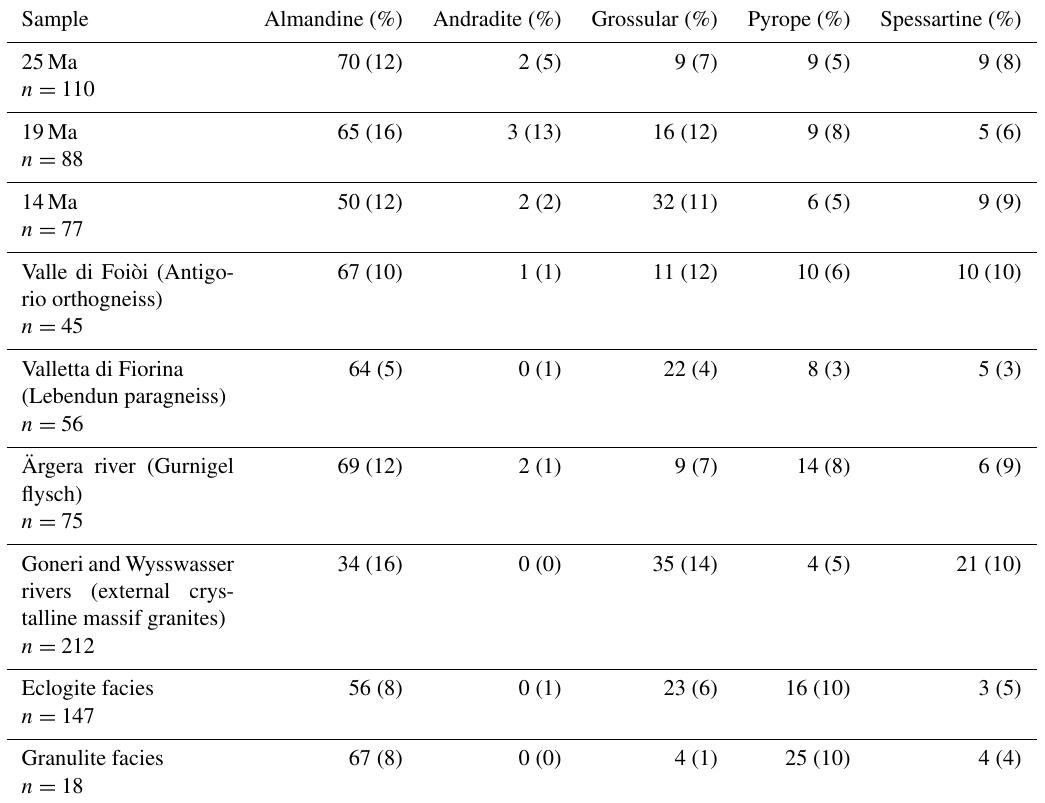
Table 3. Average contents (including standard deviation in brackets) of the five common garnet endmembers in the Molasse sandstones, the fluvial samples from the Lepontine gneisses and the Gurnigel flysch (this study), and three potential source rocks from the literature: external crystalline massif granites (Stutenbecker et al., 2017), eclogite facies rocks (Chinner and Dixon, 1973; Ernst and Dal Piaz, 1978; Oberhänsli, 1980; Sartori, 1990; Thélin et al., 1990; Reinecke, 1998; Cartwright and Barnicoat, 2002; Angiboust et al., 2009; Bucher and Grapes, 2009; Weber and Bucher, 2015), and granulite facies rocks (Hunziker and Zingg, 1980). For the full dataset we refer to Stutenbecker (2019). Sample Almandine (%) Andradite